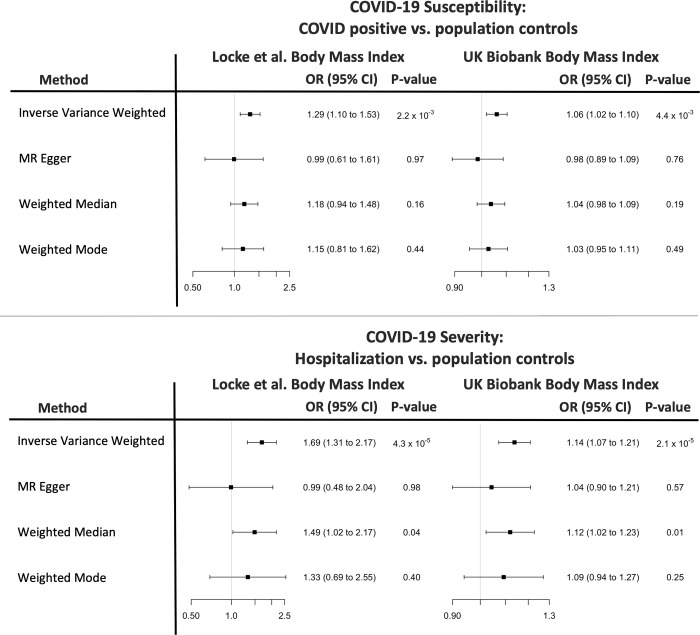
Sensitivity analyses using other Mendelian randomization (MR) methods and results using UK Biobank effect estimates.MR estimates are reported as odds ratios (ORs) per unit increase in body mass index (BMI). Locke et al. [37]: inverse normally transformed residuals; UK Biobank: kg/m2.